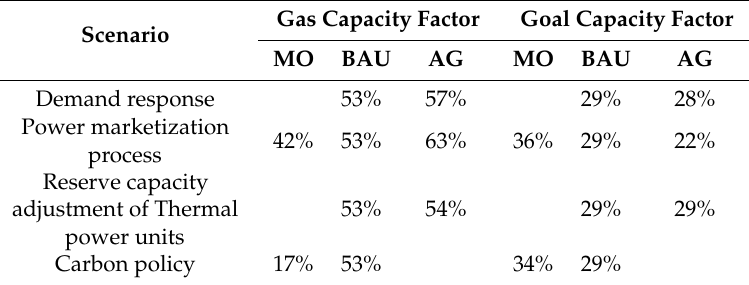
Table 18. Gas & coal capacity factors in